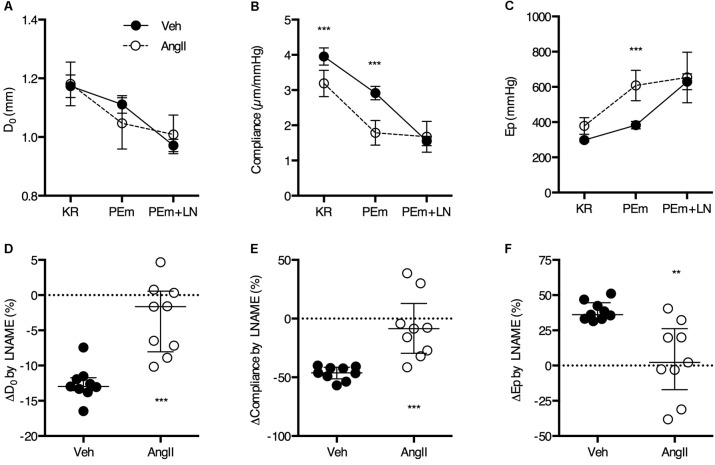
Basal NO bioavailability. Addition of 300 μM L-NAME (LN) to a maximally stimulating concentration of PE (2 μM, PEm) allows to estimate the amount of basal NO that suppresses the PEm contraction in the absence of LN (A–C). The effect of basal NO blockade (i.e., LN effect) relative to the magnitude of the PEm effect was almost zero in AngII-treated mice (n = 10) and significantly smaller as compared to vehicle-treated mice (n = 9) (D–F). Two-way ANOVA with Bonferroni post hoc test for multiple comparisons, there was a significant interaction between the treatment and VSMC contraction factor for D0 (P > 0.001), compliance (P < 0.001) and Ep (P < 0.05) (A–C). Mann–Whitney test (D–F)
∗, ∗∗, ∗∗∗P < 0.05, P < 0.01, P < 0.001 vs. vehicle. Line and error bars represent mean and 95% confidence intervals (A–C) or median and interquartile range (D–F), respectively.